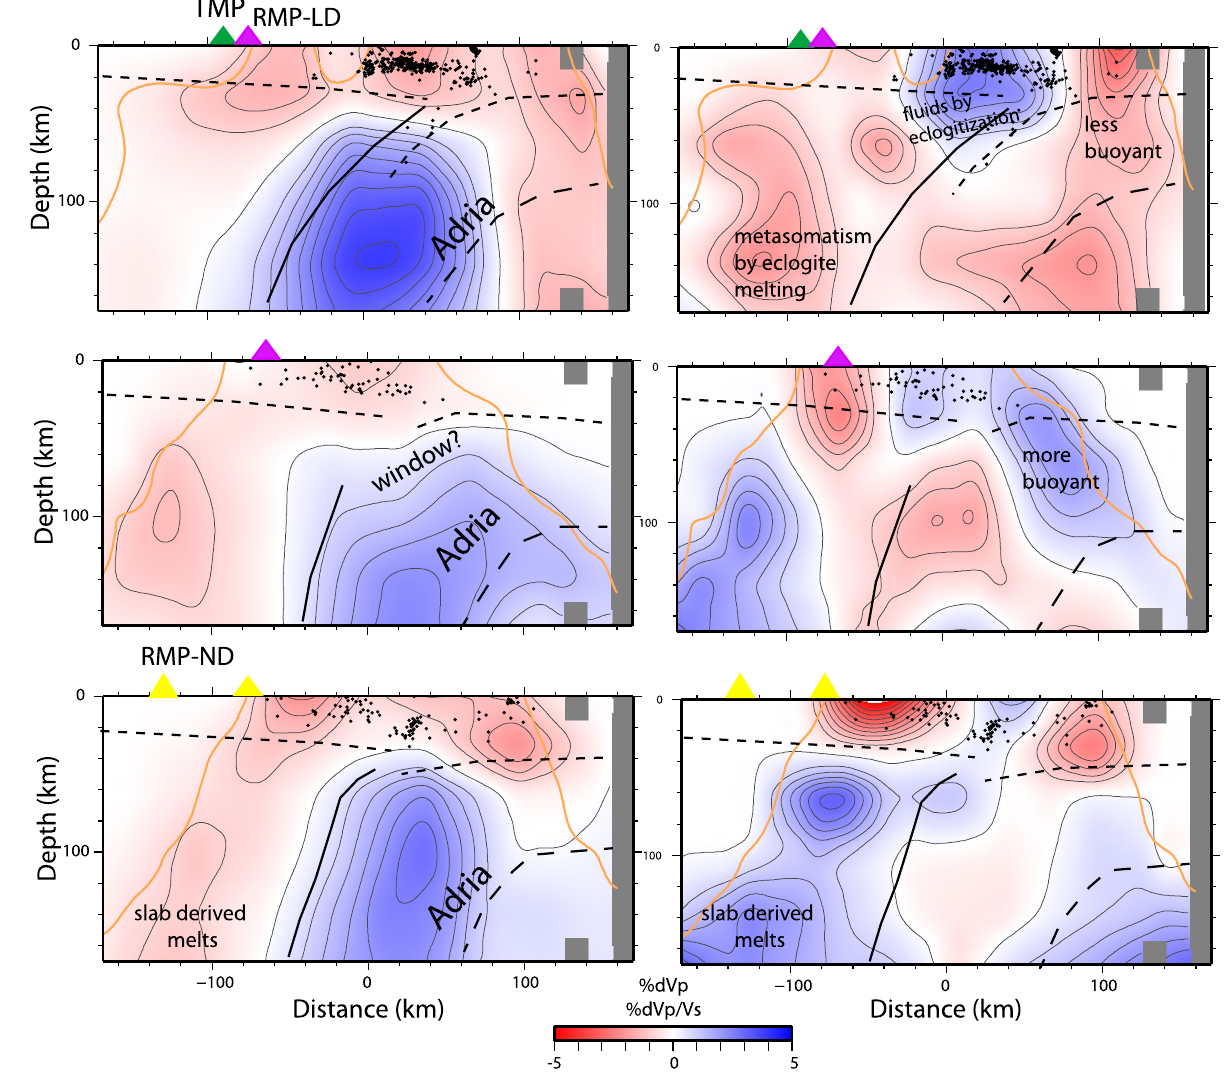
Figure 3. Vertical section of Vp and Vp/Vs in three sections across the Apennines subduction (north, central, south). Dots are seismicity and the geometry of the Moho depth from RFs study 26 is shown by dashed lines. Triangles are the location of main magmatism. The orange line is the limit of the resolved region according to the